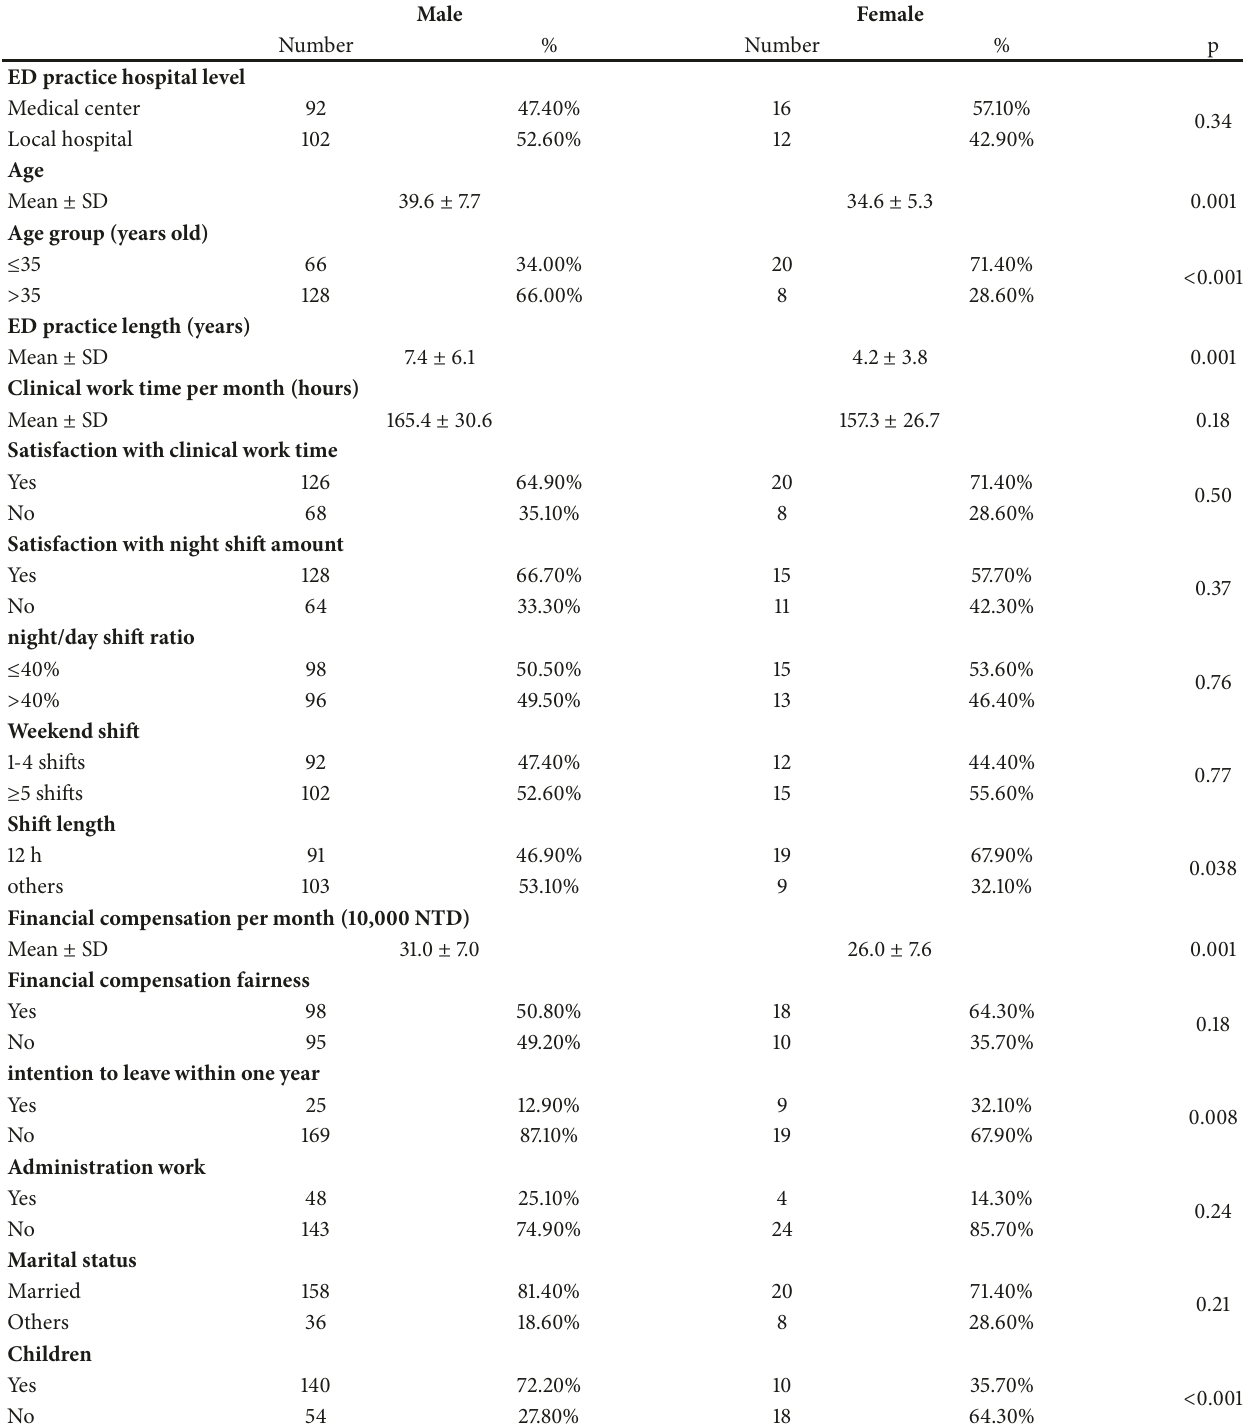
Table 3: Gender differences in emergency